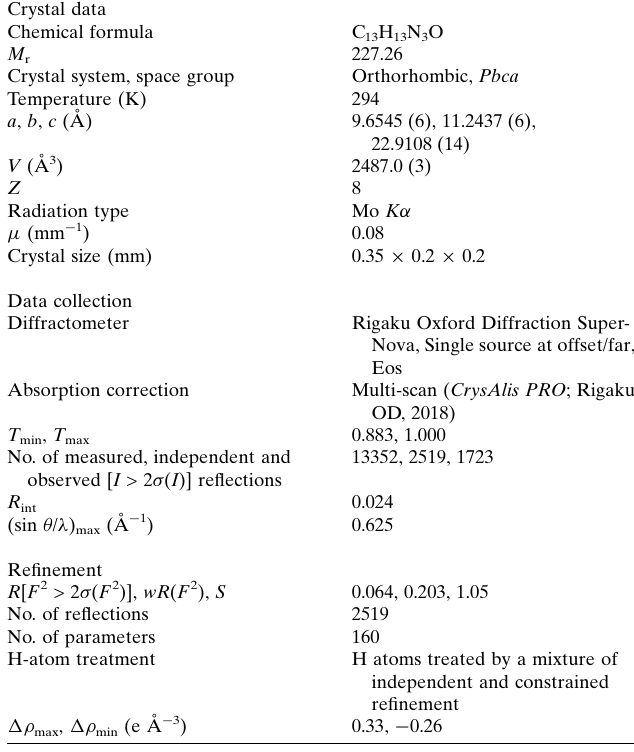
Table 4 Experimental details. Crystal data Chemical